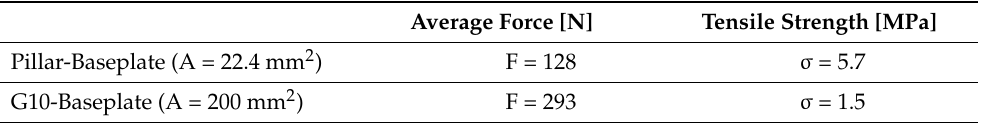
used in the comparison with measurements (modal testing) and calculations below. Table 2. The results of the tensile test. The average force is calculated from the three different measurement. The areas of the different specimens are also